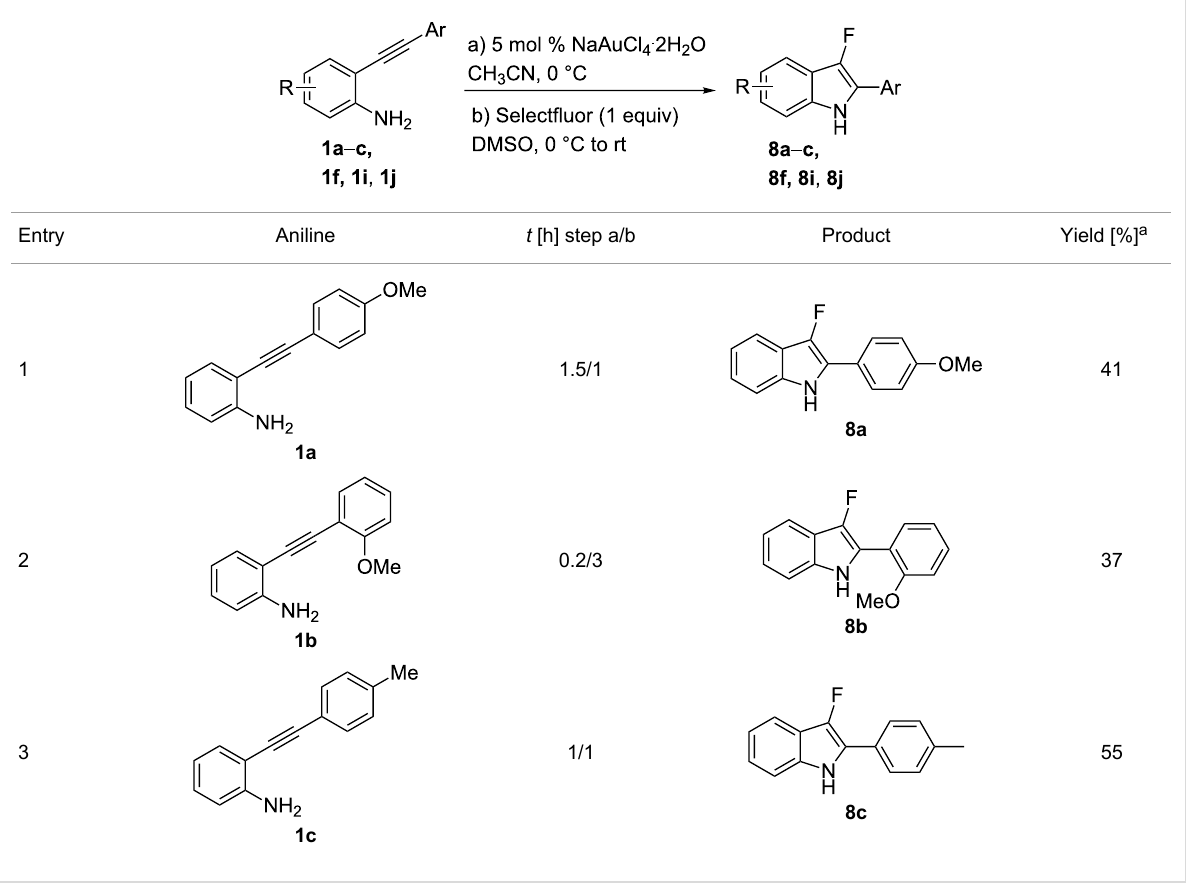
Table 3: Cycloisomerization/fluorination reaction of 2-alkynyl-substituted anilines.